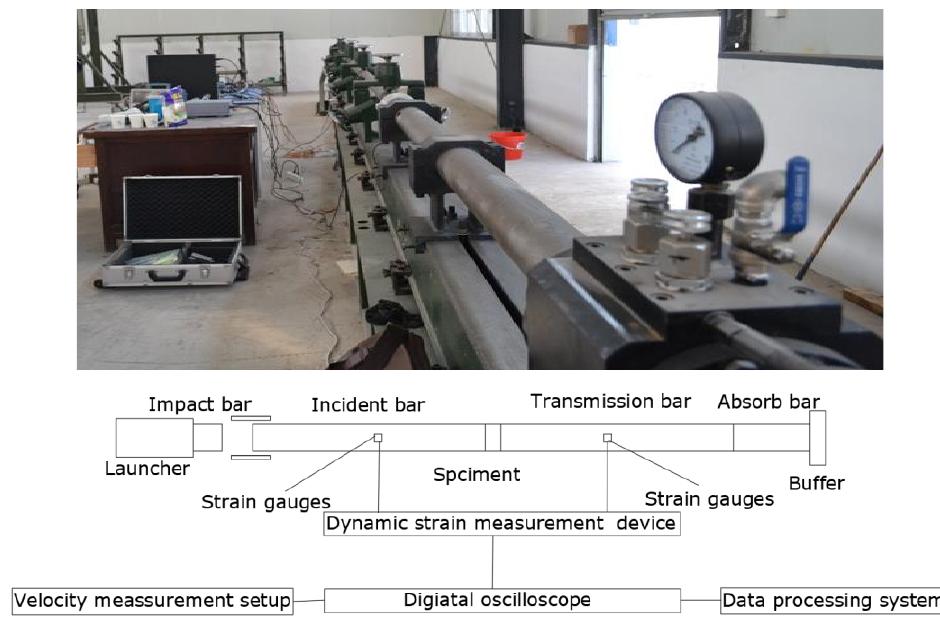
Figure 7. Diagram of the experimental setup.